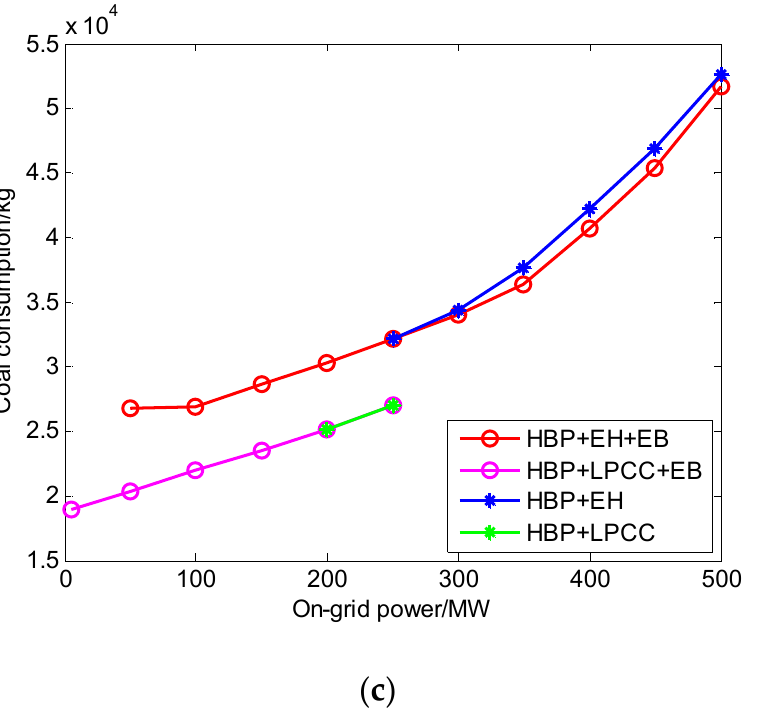
Figure 6. Coal consumption in different unit commitment modes. ( a ) Heat load 300 MW. ( b ) Heat load 400MW. ( c ) Heat load 500 MW.